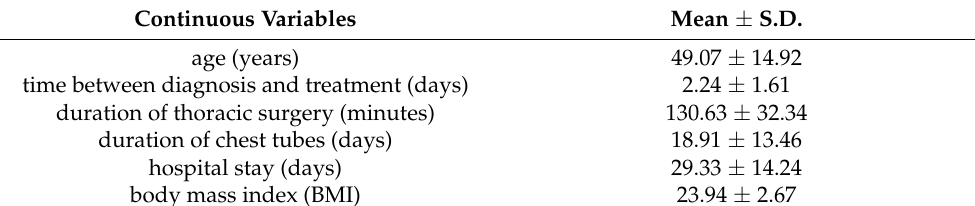
Table 1. Data relating to the continuous variables, expressed as mean ± standard deviation (s.d.). Continuous Variables